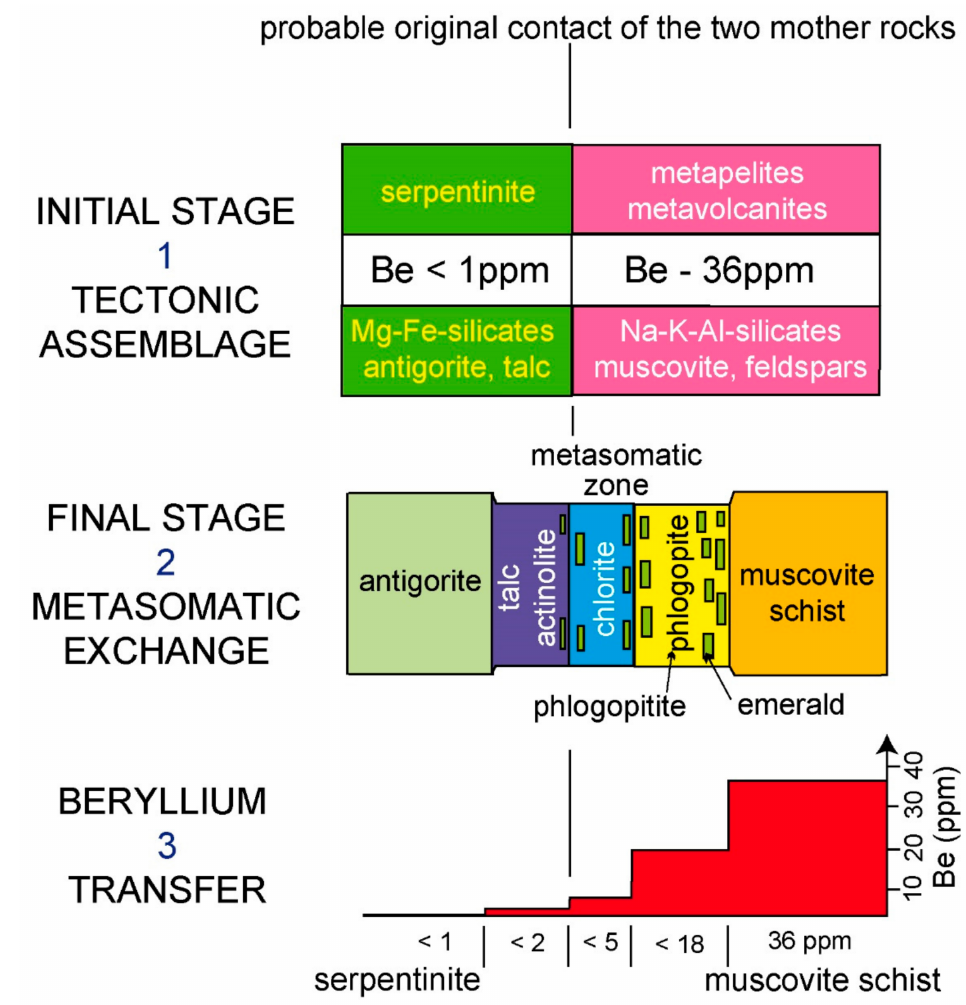
Figure 22. Model of formation of the Habachtal emerald deposit: ( 1 ) Initial stage showing the different lithologies with their respective Be contents; ( 2 ) final stage after regional metamorphism showing the final metasomatic rocks assemblages; ( 3 ) beryllium liberated from the muscovite schists is incorporated into the emerald